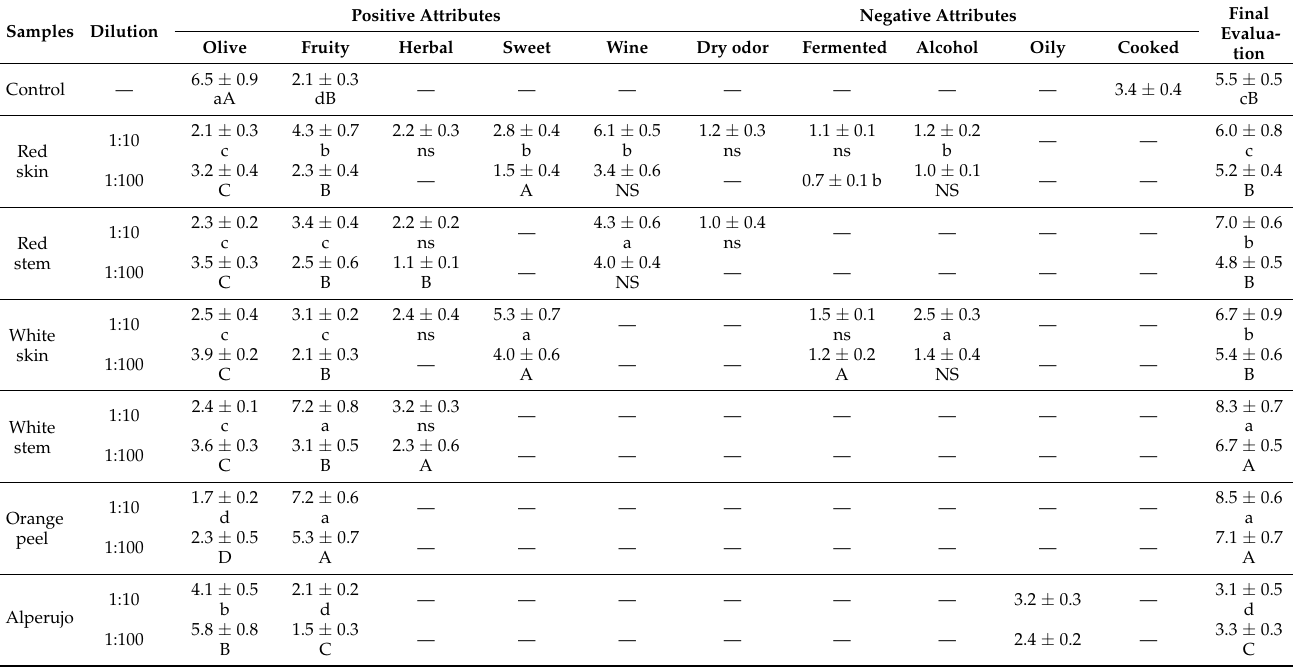
Table 2. Sensory analysis of stuffed Californian-style black olives with the addition of different concentrations of by-products. Different lowercase letters mean a statistically significant difference between the dilution 1:10 (Tukey’s test p < 0.05). Different capital letters mean significant differences between the dilution 1:100 (Tukey’s test p < 0.05).